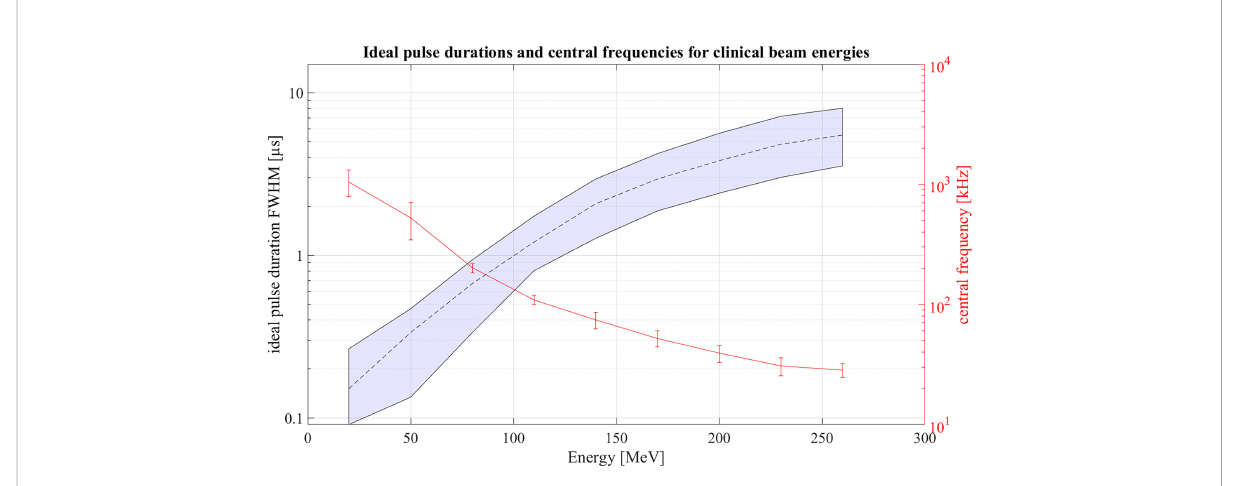
FIGURE 13 Ideal pulse durations for clinically relevant energies assuming Gaussian pulse shapes. Within the shaded area 90% of the maximum possible SNR D,C can be reached. On the right y-axis the central frequencies of the signals generated with ideal pulse duration is